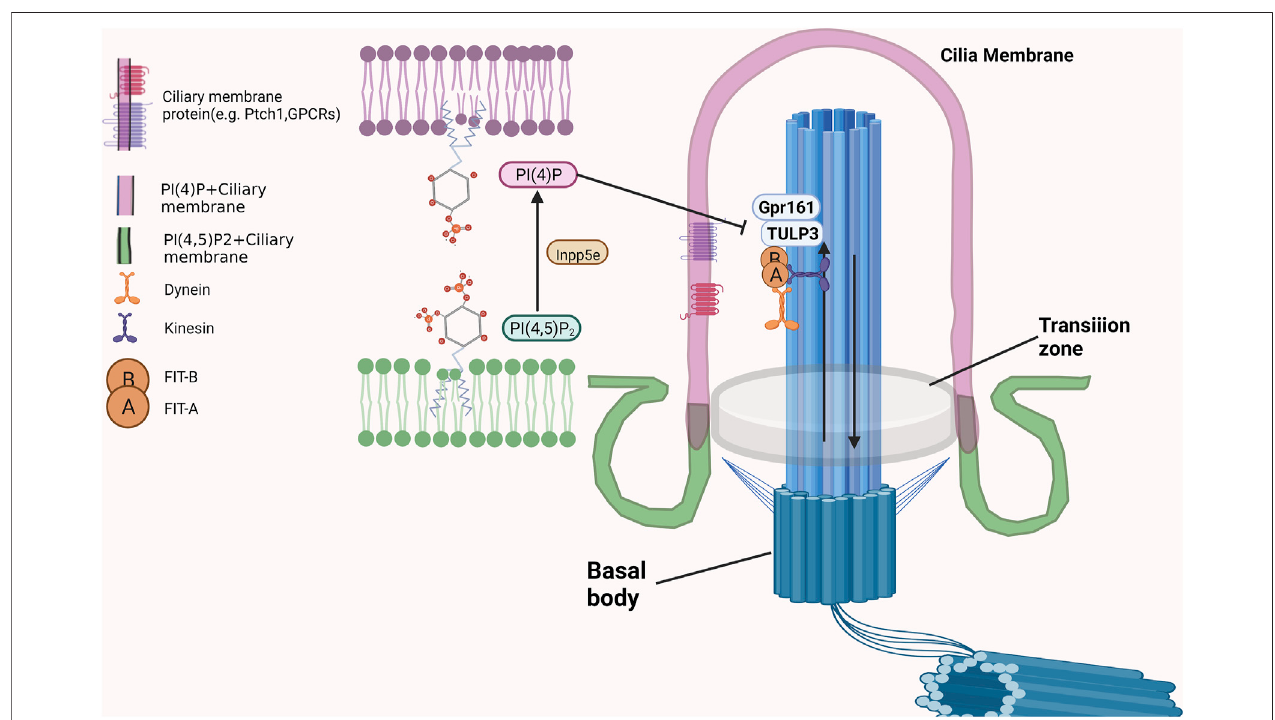
FIGURE 2 | The critical roles of INPP5E in maintaining the PIs on cilia